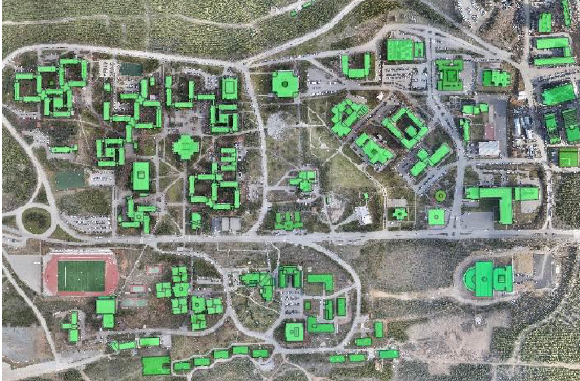
Figure 4. Overview of the building